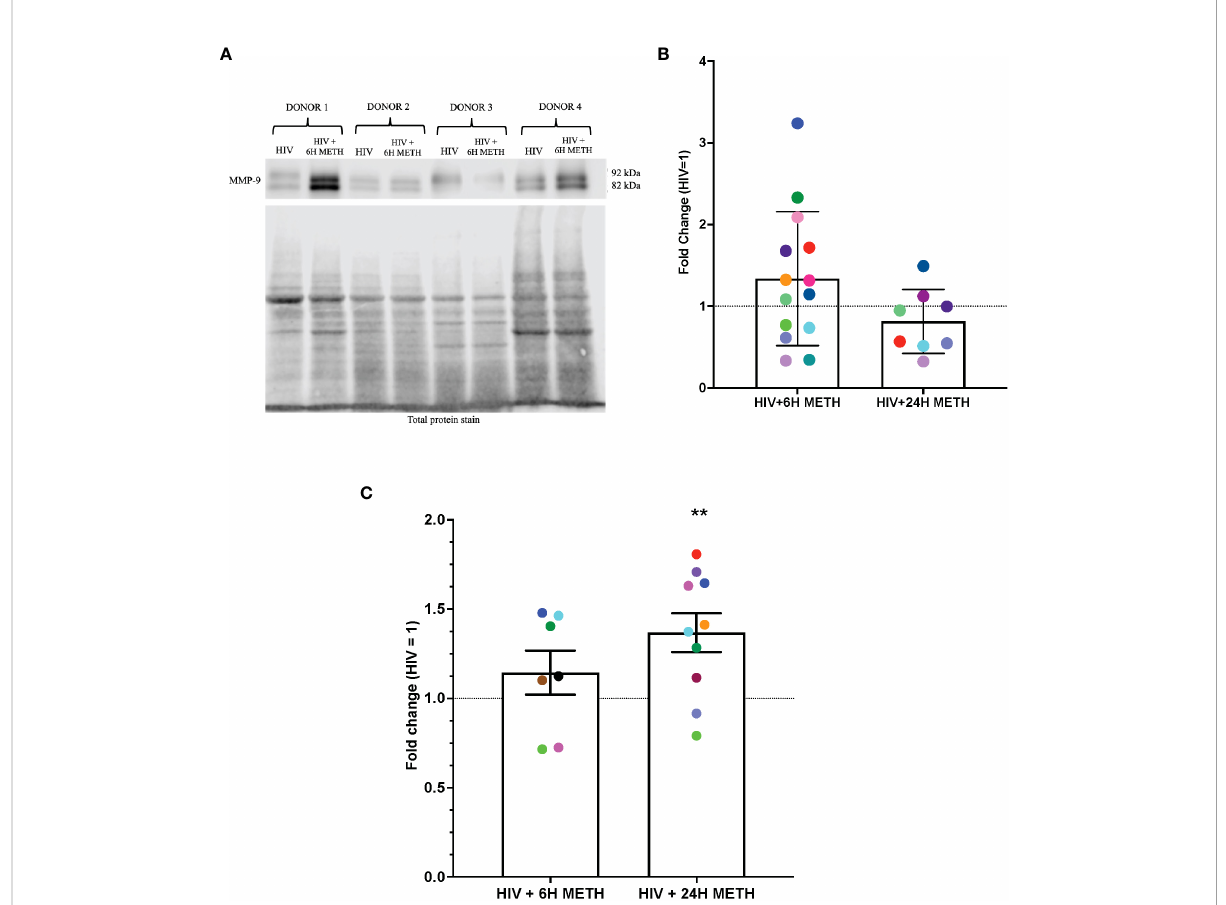
FIGURE 4 MMP-9 protein is increased in HIV-infected mature monocytes treated with meth. (A) A representative western blot with corresponding total protein stain of HIV-infected mature monocytes either untreated or treated for 6 h with meth. (B) Fold change of normalized MMP-9 protein from HIV-infected mature monocytes treated with meth over untreated HIV-infected mature monocytes. Each colored dot represents an individual donor. The columns and error bars depict mean and standard deviation (SD), respectively. n=7 – 14. (C) Fold change of normalized MMP-9 protein in supernatants of HIV-infected mature monocytes treated with meth over untreated HIV-infected cells. Each colored dot represents an individual donor. The columns and error bars depict mean and standard error of the mean (SEM), respectively; n=7-10; **, p<0.005 by the one sample